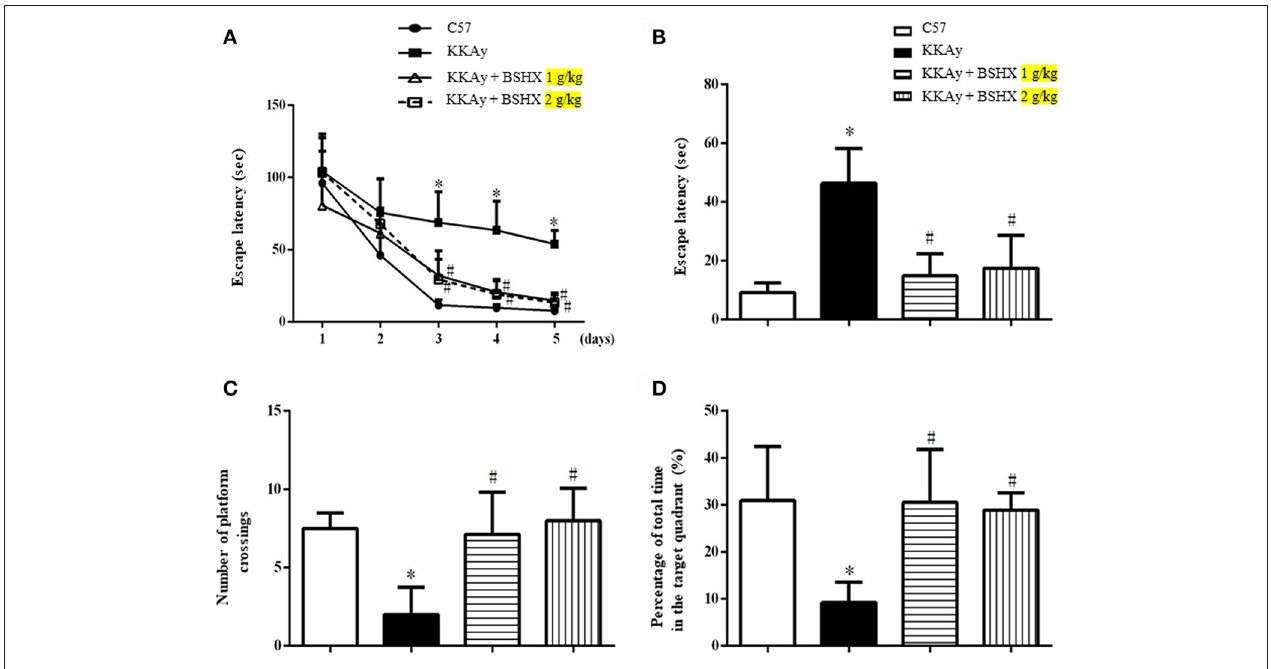
FIGURE 2 | The effect of BSHX on spatial memory of mice. (A) The mean latency time during the training period. (B) The latency to platform in the probe trial. (C) The number of platform crossings during the spatial probe test. (D) The percent of total time spent in the target of quadrant during the spatial probe test. Data were expressed as mean ± SD ( n = 6). * p < 0.05 vs. C57 group, # p < 0.05 vs. KKAy group.